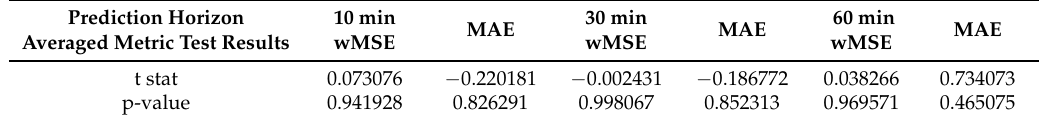
Table 2. Significance of difference between the top 2 configurations of DCPN using Welch’s t-test. Prediction Horizon Averaged Metric Test Results